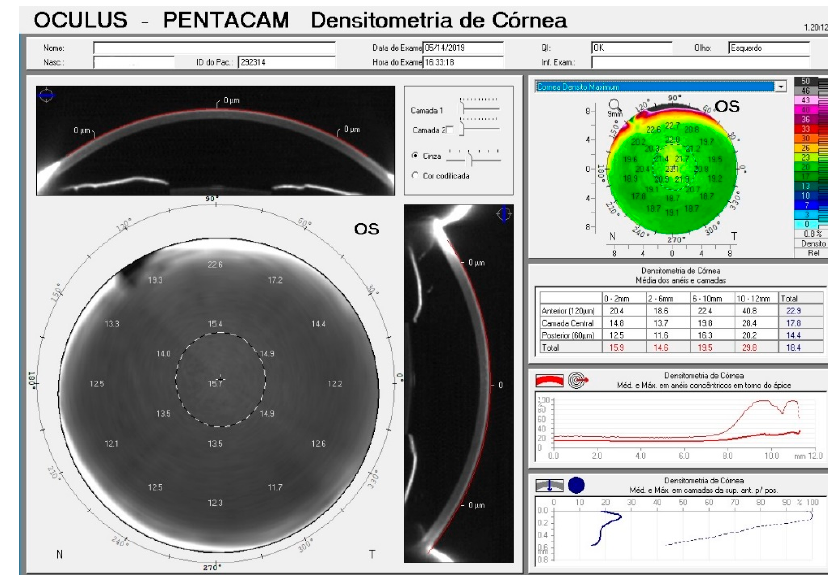
Figure 1. Pentacam Densitometry map for the left eye of a patient included in the study.